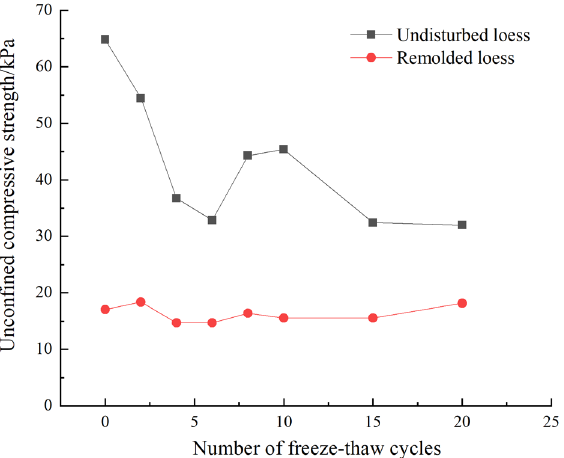
Figure 10. Relationship between the compressive strength of loess and the number of freeze–thaw cycles at different freeze–thaw cycles.